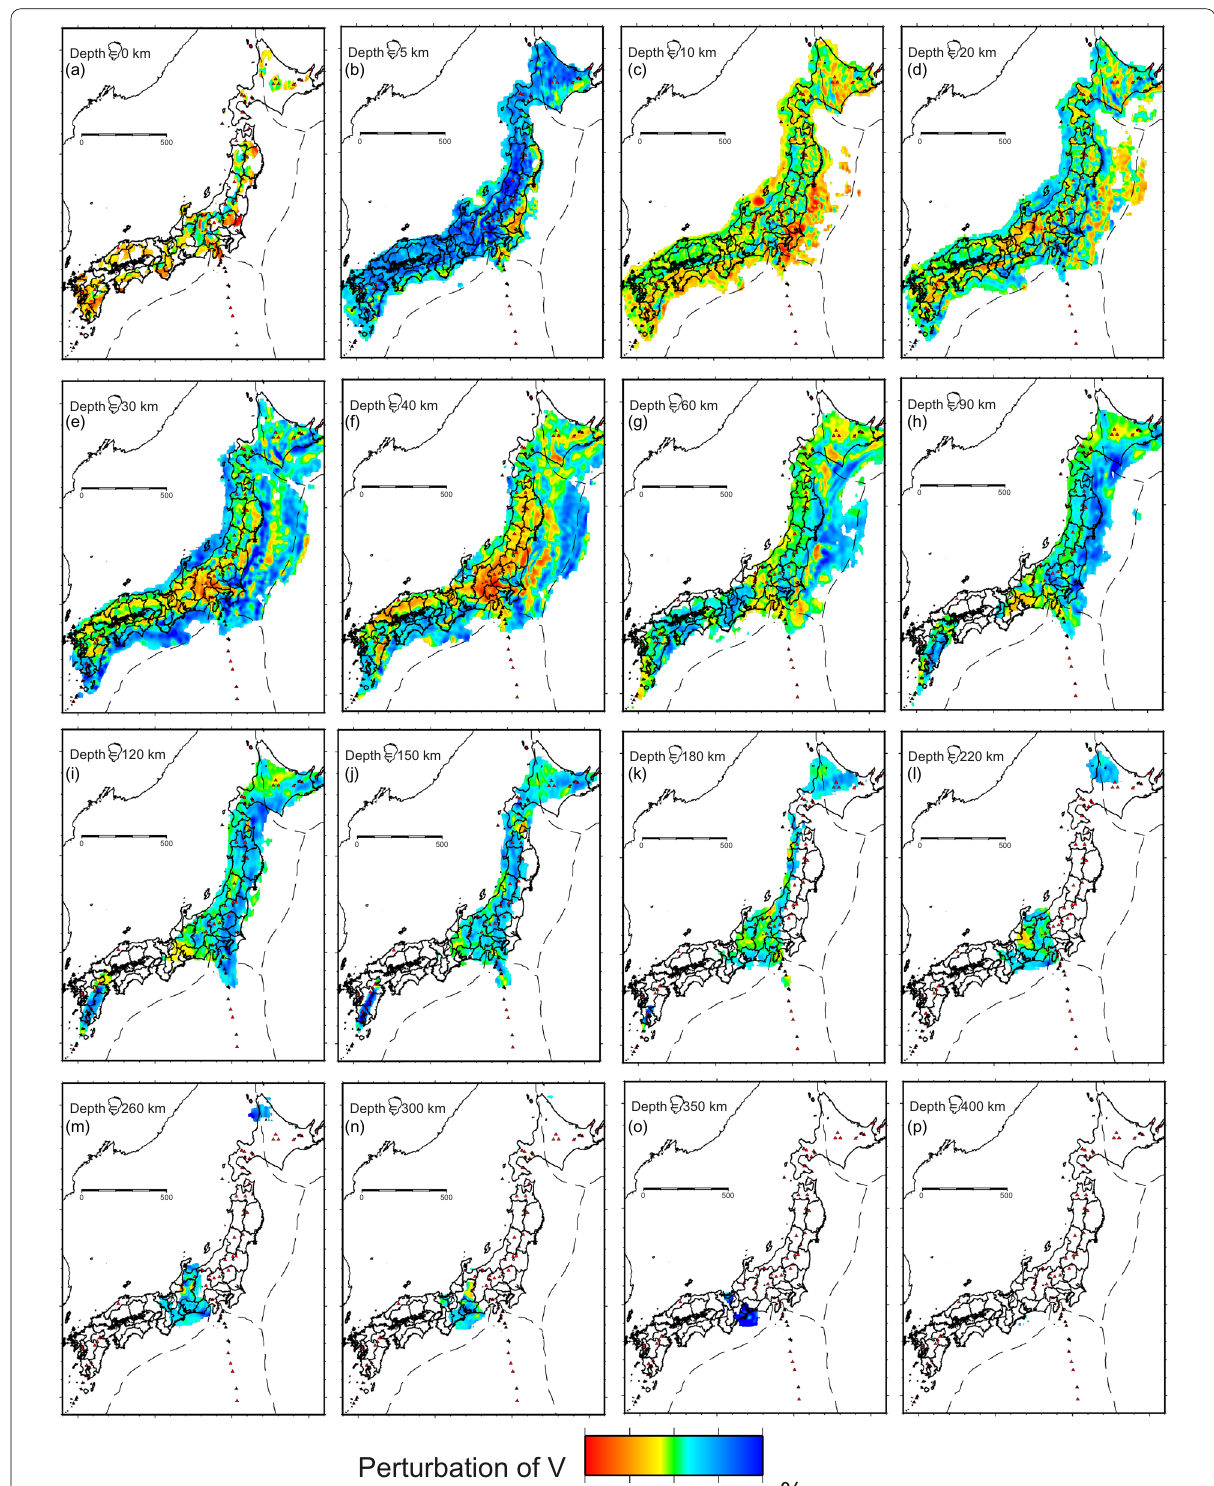
Fig. 11 Map views of Vs perturbation beneath Japanese